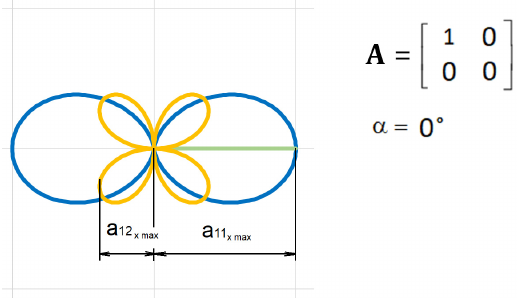
Figure 15. Symmetric tensor with 𝛼 = 0°